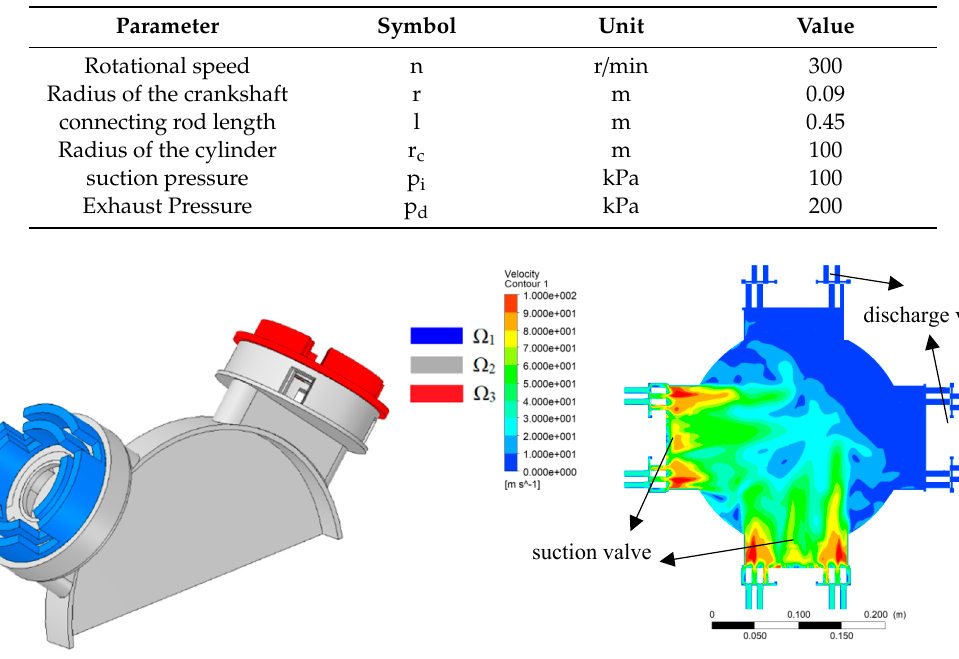
Figure 3. Outline diagram of reciprocating compressor and velocity cloud diagram during suction.